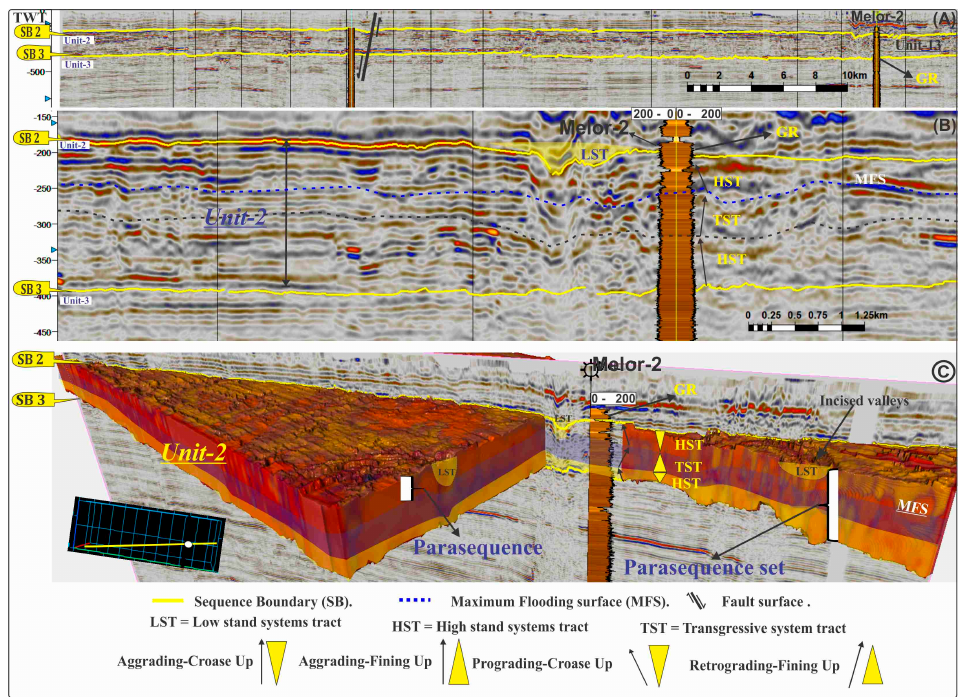
Figure 13. ( A ) A regional seismic cross-section of unit 2. ( B ) A detailed explanation of sequence boundaries of unit 2. ( C ) Visualization of unit 2 with systems tract, faults, parasequences, and parasequences set.